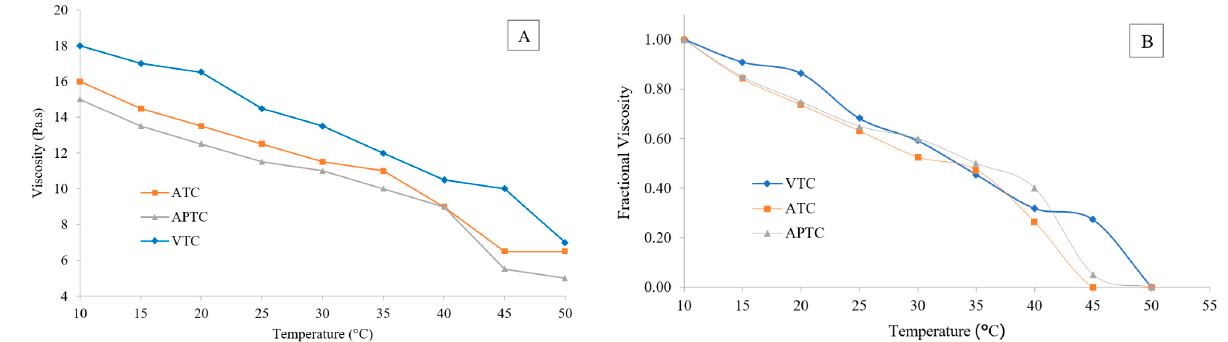
Figure 5. Viscosity ( A ) and fractional viscosity ( B ) of tuna-tail-tendon collagen (VTC: acid-solubilized collagen using vinegar extraction, ATC: acid-solubilized collagen using acetic-acid extraction, and APTC: pepsin-solubilized collagen).